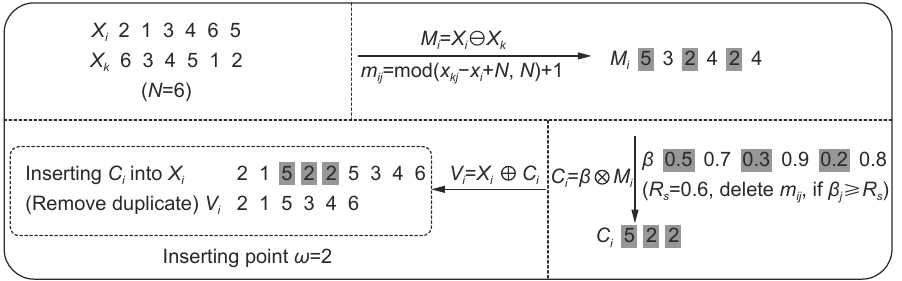
Fig. 5 Example for generating a candidate solution V